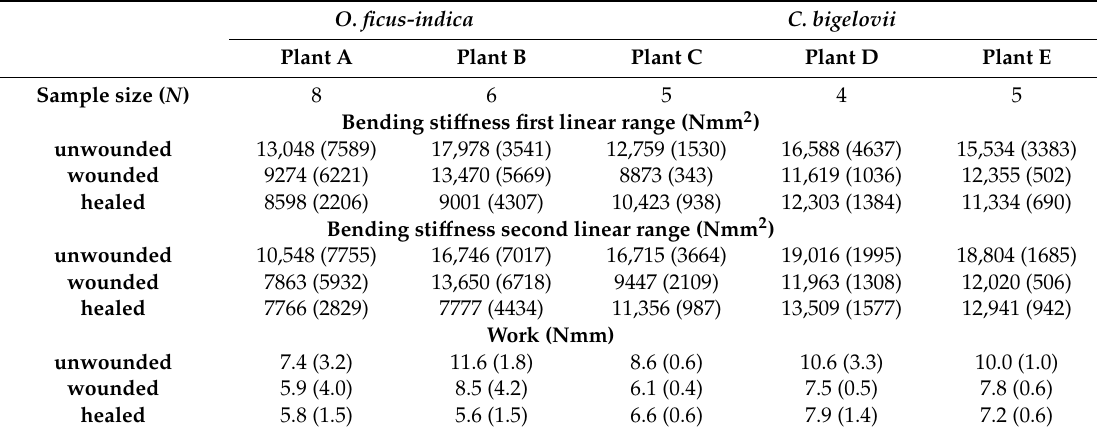
Table 2. Median values with respective interquartile ranges (IQR) of the mechanical parameters presented for the individual plants A and B of O. ficus-indica and plants C–E of C. bigelovii . O. ficus-indica C. bigelovii Plant A Plant B Plant C Plant D Plant E Sample size ( N